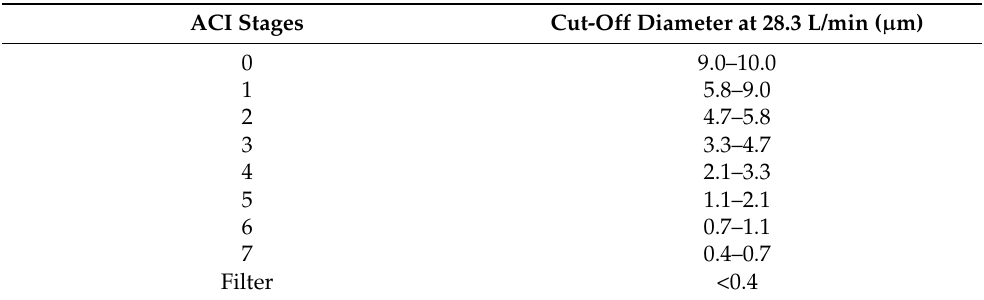
Table 3. Cut-off aerodynamic diameter for stages of Andersen cascade impactor (ACI) at a flow rate of 28.3